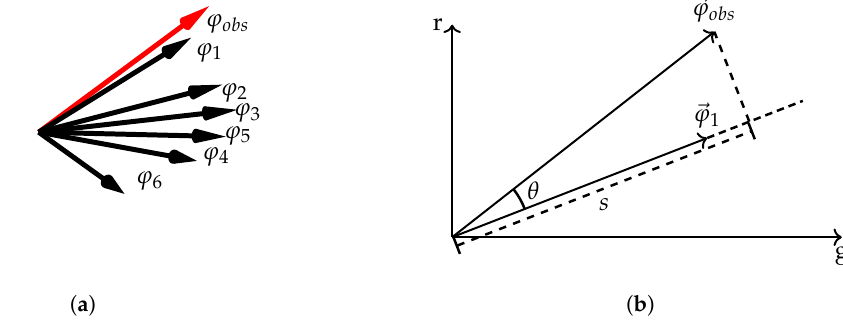
Figure 1. Visualization on how dictionary based spectral reconstruction propagates the signal scale to the spectral domain. In the simplest case, the associated atom for an observed camera signal is the nearest neighbor of the dictionary ( a ). The signal scale is extracted by vector projection ( b